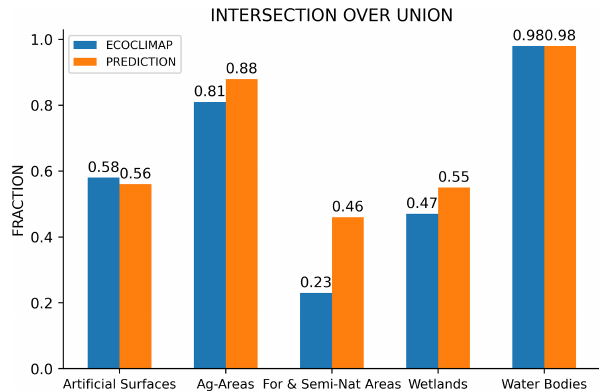
Figure 5. Proportion of each of the 4 Primary land-cover types for each of the 3 maps shown in Fig. 4. The Water bodies label is omit- ted for easier comparison of the terrestrial land-covers.